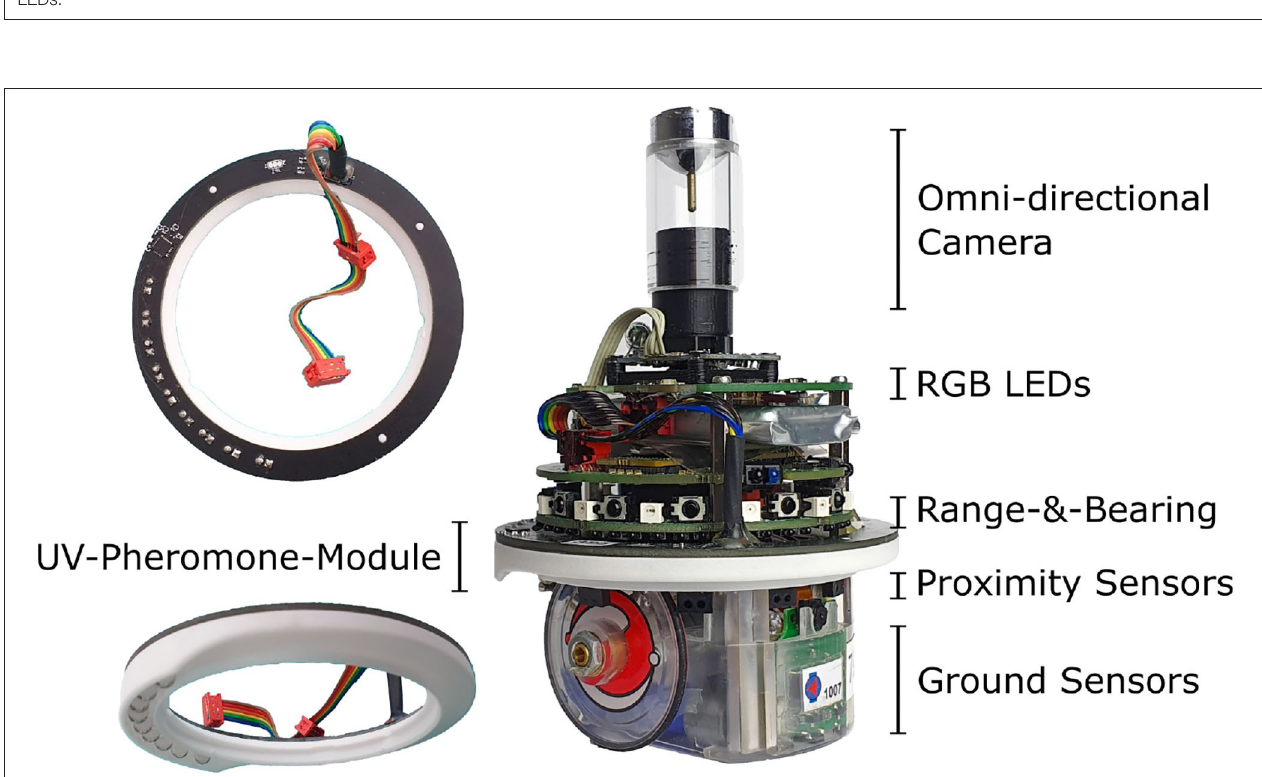
FIGURE 2 | Extended version of e-puck equipped with UV-pheromone-module and omni-directional camera.